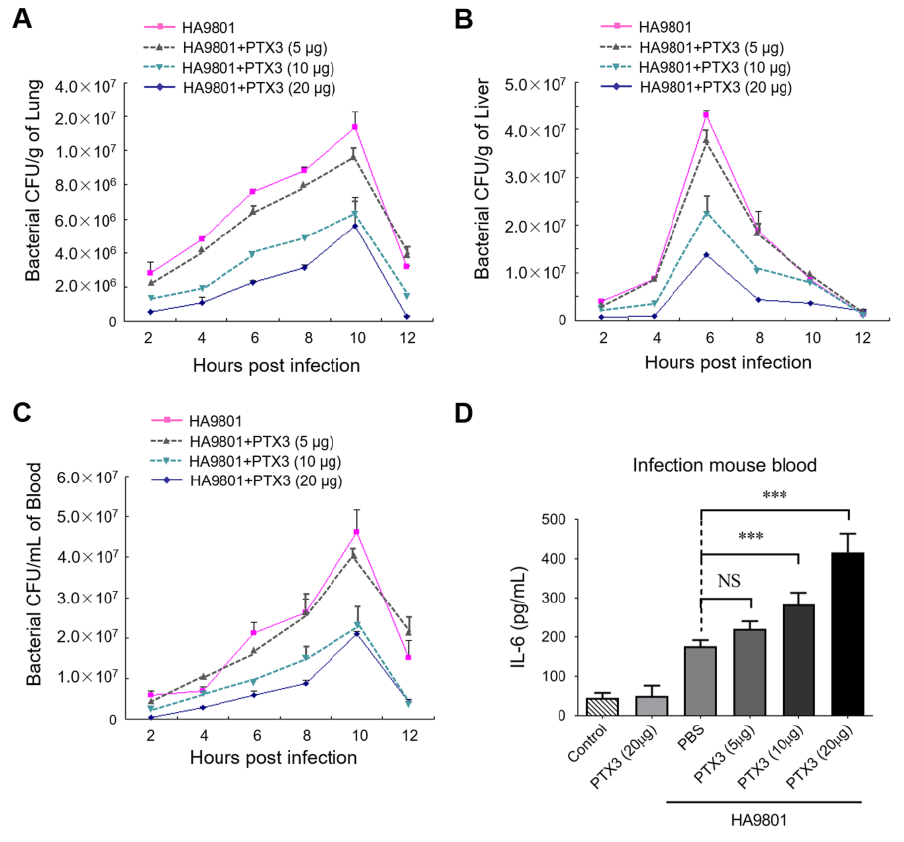
Figure 4. PTX3 significantly reduced the bacterial load in the organs during the HA9801 infection. Bacterial loads in mouse lung ( A ), liver ( B ), and blood ( C ) were detected from 2 to 12 h post-infection, with or without the co- treatment of PTX3 (5, 10 or 20 μg). ( D ) The levels of IL-6 in the HA9801-infected bloods with the co- treatment of PTX3 (5, 10 or 20 μg). Data were shown as the mean ± SEM of three independent experiments performed in triplicate. Statistical significance was determined by a Student’s t -test based on comparisons with the PBS group (*** p < 0.001).